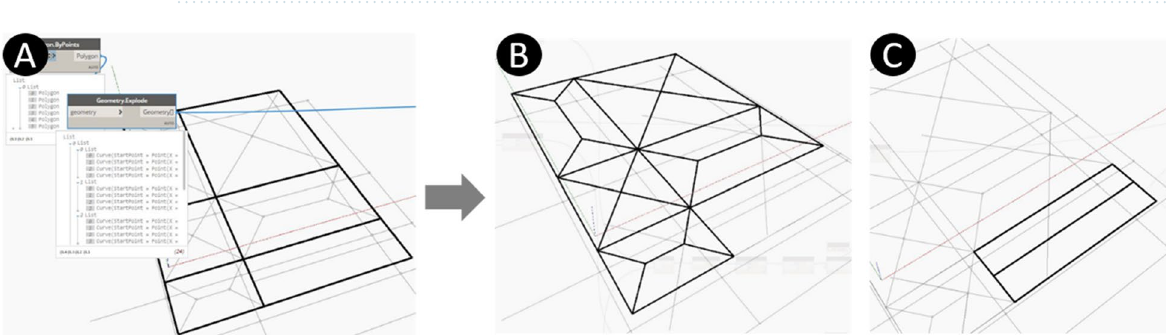
Figure 8. Load distribution of the floor slabs ( A ) Polygons representing slabs and curves representing beams, ( B ) Load distribution (two-way slab), ( C ) Load distribution (One-way